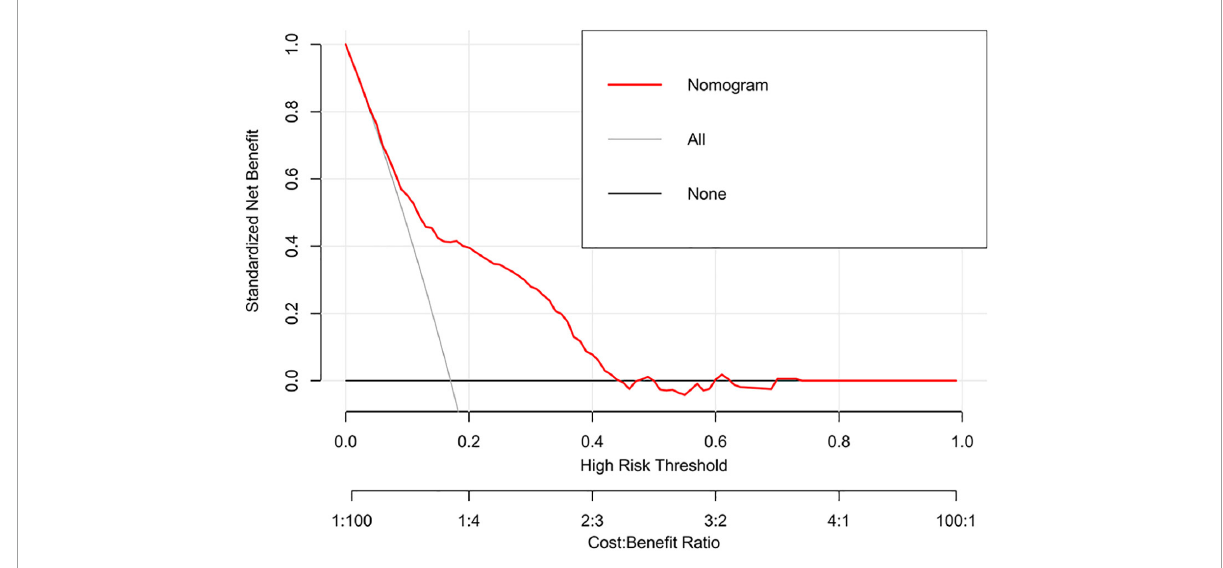
FIGURE5 Decision curve analysis (DCA) of the nomogram in the training